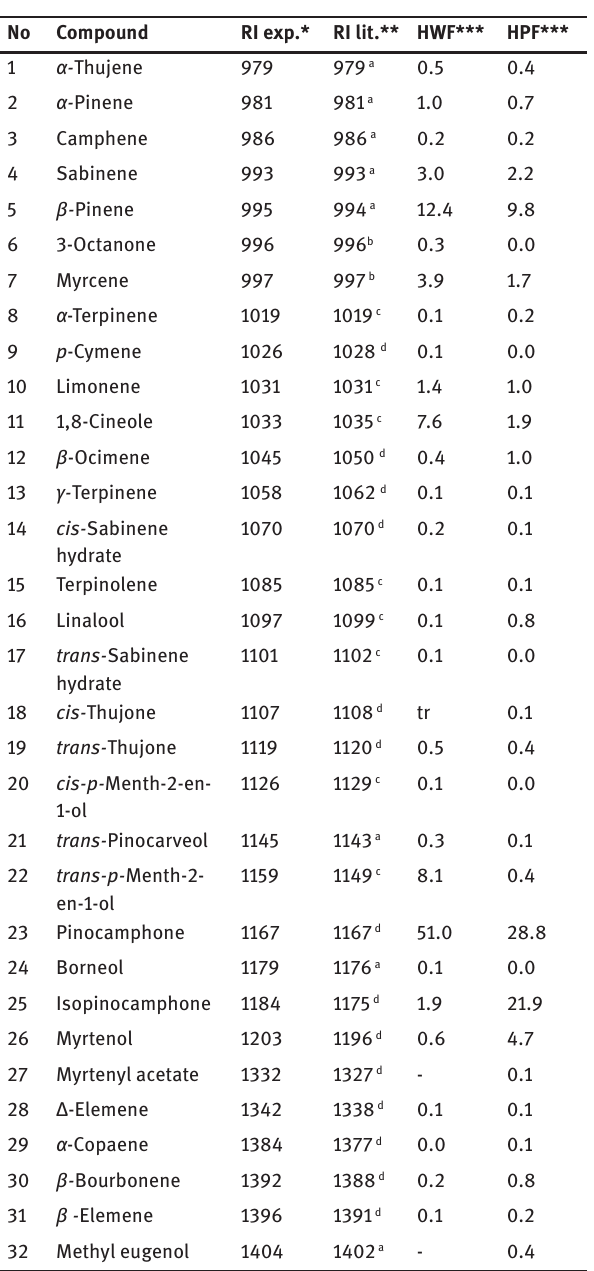
Table 1: Percentage composition of essential oil obtained from white- (HWF) and pink- (HPW) flowered Hyssopus officinalis